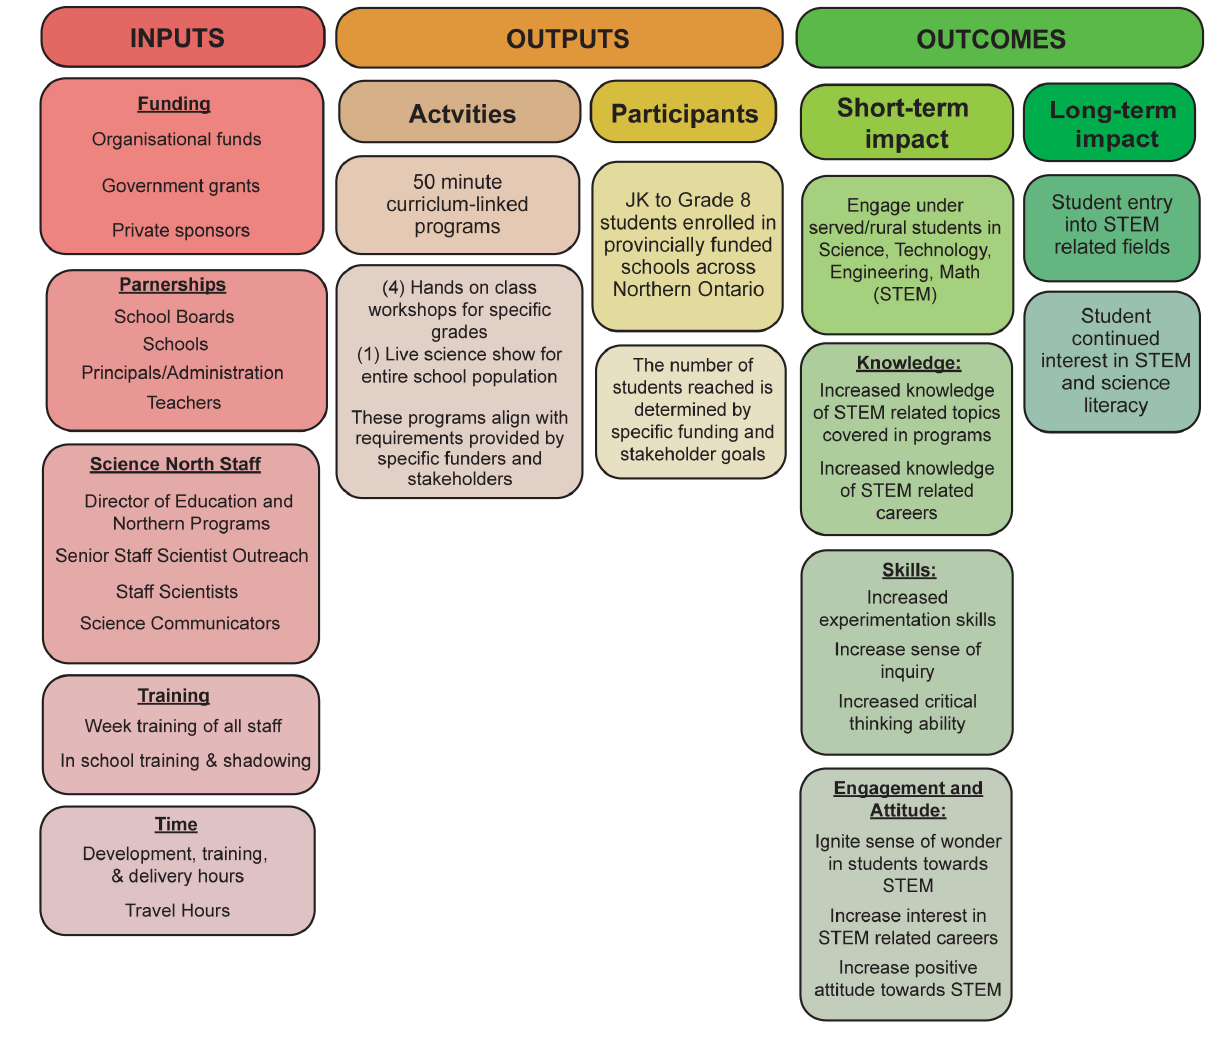
FIGURE 1 | Science North provincially funded in-school outreach initiatives logic model. This logic model demonstrates the inputs and outputs of Science North in-school outreach programs as well as the measurable outcomes that were evaluated throughout this